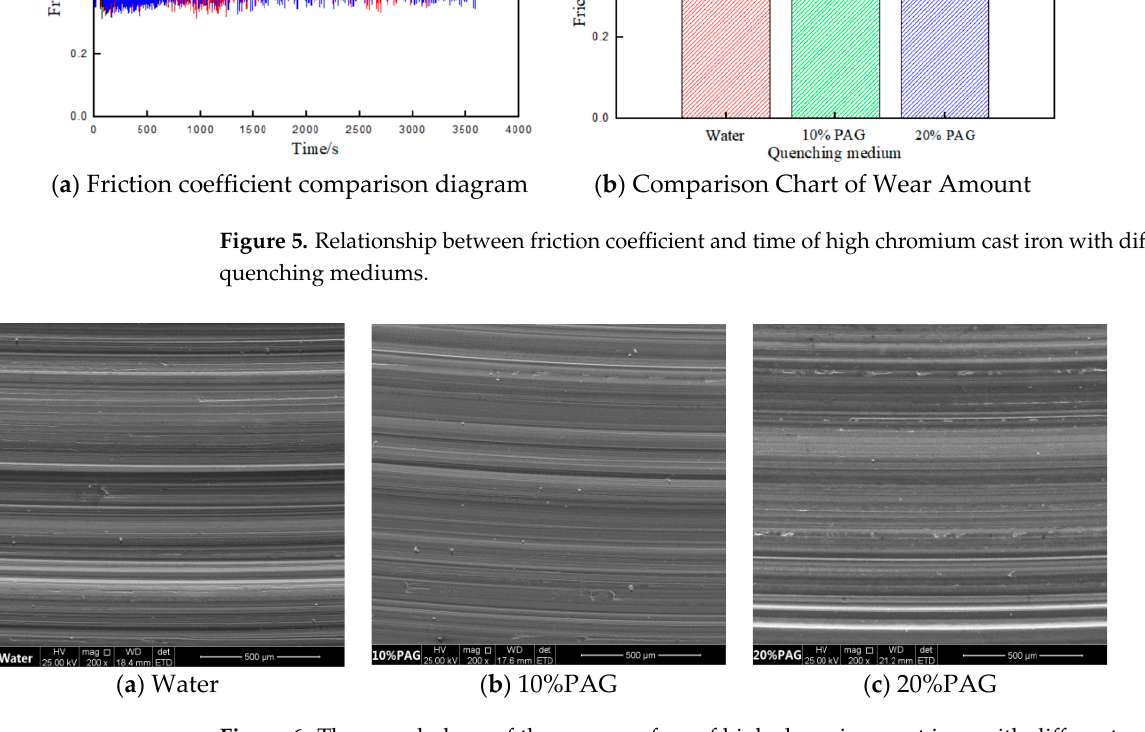
Figure 6. The morphology of the worn surface of high chromium cast iron with different quenching mediums.